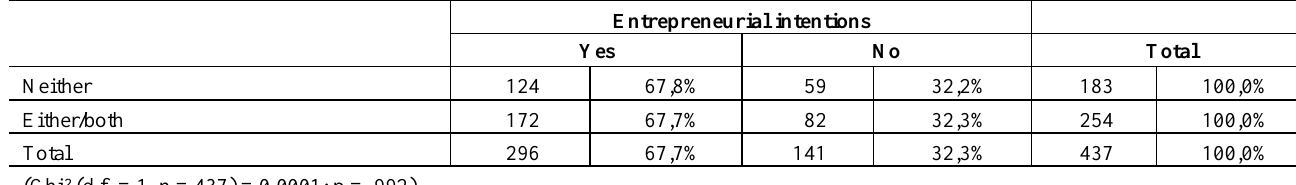
Table 5: Self-employment status of parents and entrepreneurial intentions